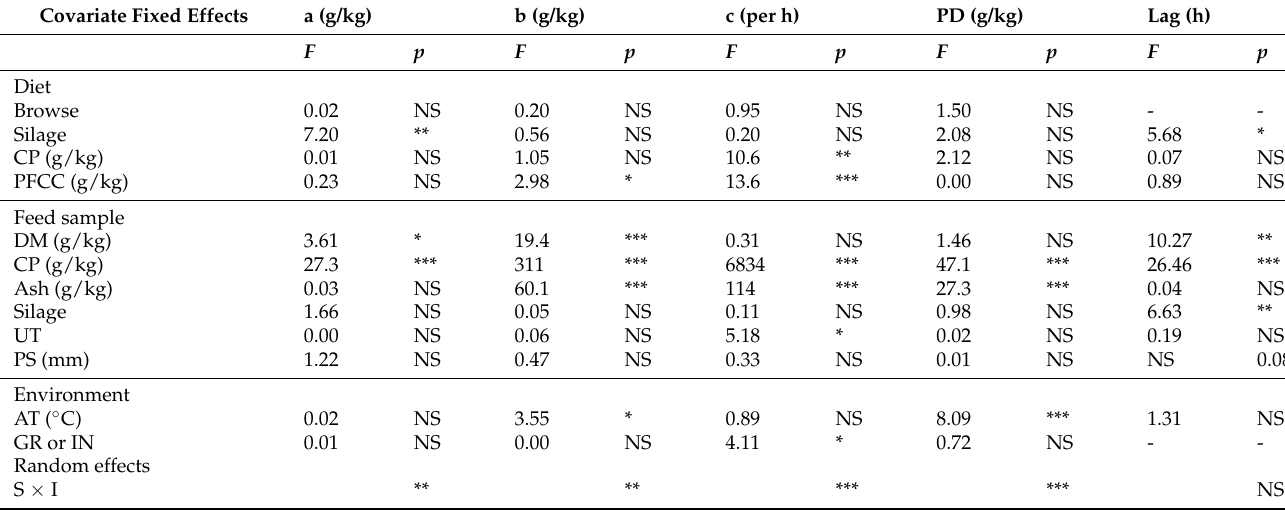
Table 4. Covariate effects of feed sample and diet properties, ambient temperature and climatic region on rumen degradation of feeds.